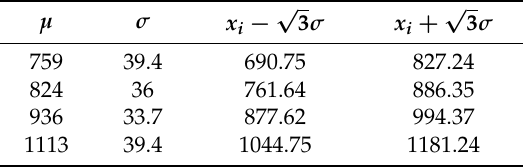
Table 4. Flow rates used to evaluate the performance function with the point estimate